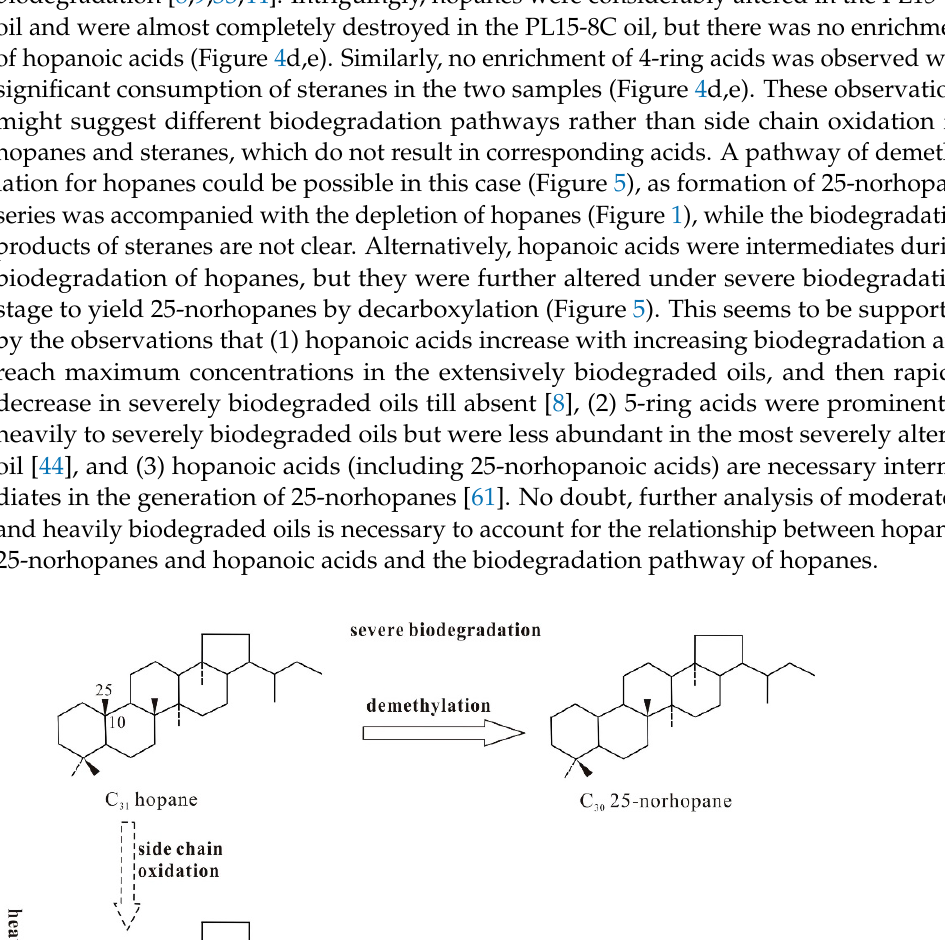
31 hopane as an